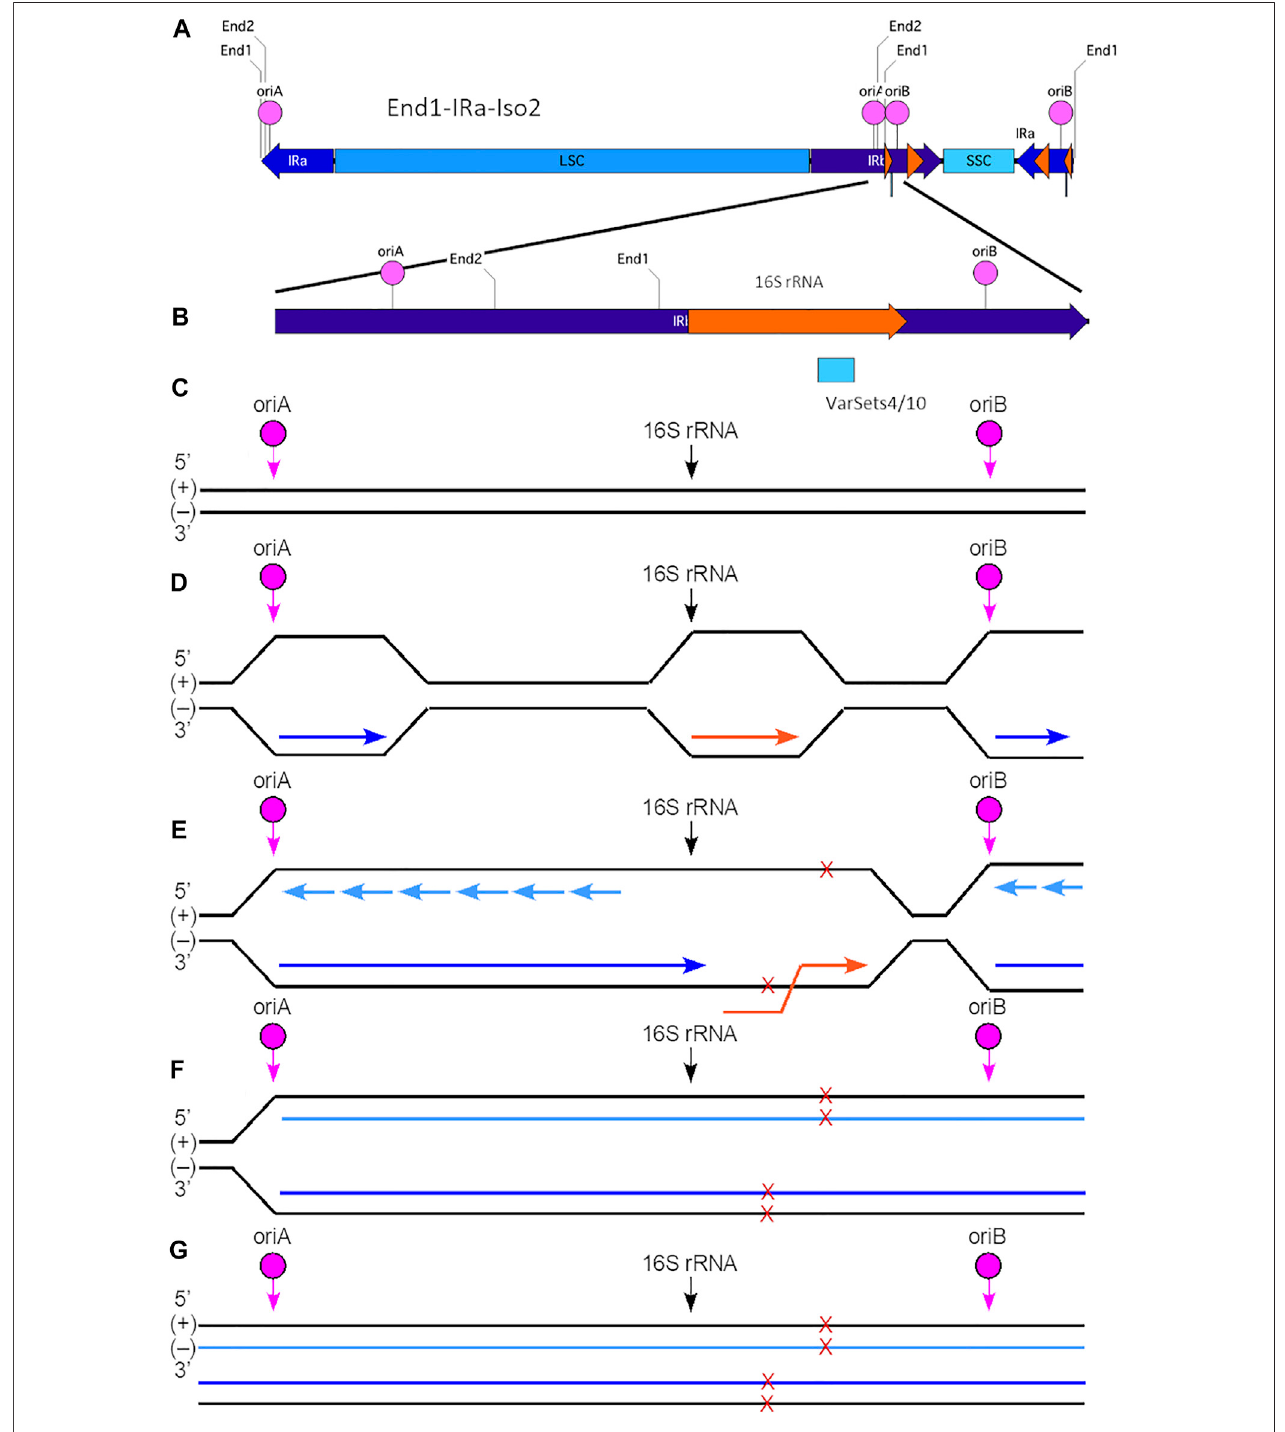
FIGURE 6 | Model for generation of plastid ptDNA variants caused by co-directional replication-transcription con fl ict. (A) The plastid DNA molecular isomer used for this model is End1-IRa-Iso2. In this isoform, the IRb (nt 82356-105103) is located internally between the LSC and SSC and contains both oriA (nt 93170-93455) and oriB (nt 97174-97296). The 16S rRNA gene (nt 95164-96654; coding on (+) strand) is located between these two origins of replication. The variant Cluster 1 (VarSets4/ 10;ntrange96098-96298)isfoundwithinthe16SrRNAgenicregion.Thenucleotide(nt)numberingcorrespondstothemaizeplastidreferencegenome.Thesmall orangearrowheadindicatesthelocationofthe16SrRNAgene,andlargeorangearrowheadthelocationofthe23SrRNAgene. (B) ExpandedviewofasegmentofIRbin isomer End1-IRa-Iso2, which spans a total of 5,500 nts (nt 93276-97876). The Cluster one region includes 34 variants which span a total of 200 nts and is shown as a